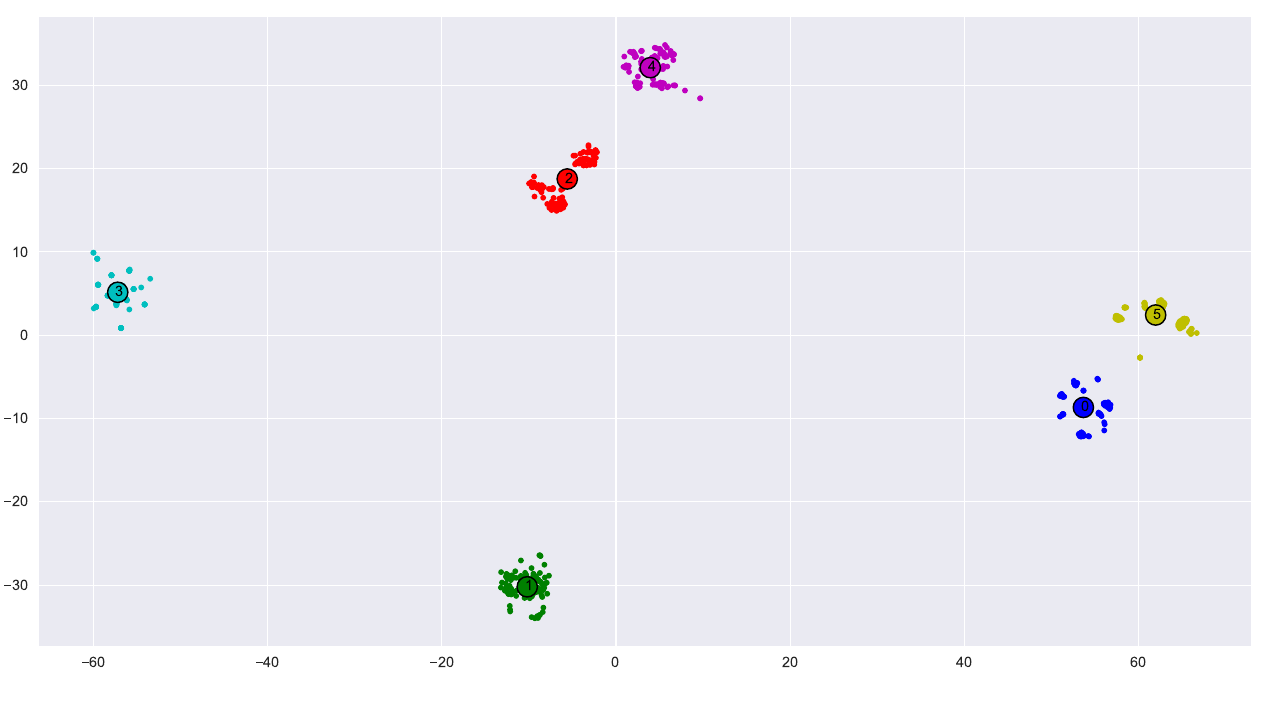
Figure 9. Mean shift for unsupervised clustering.